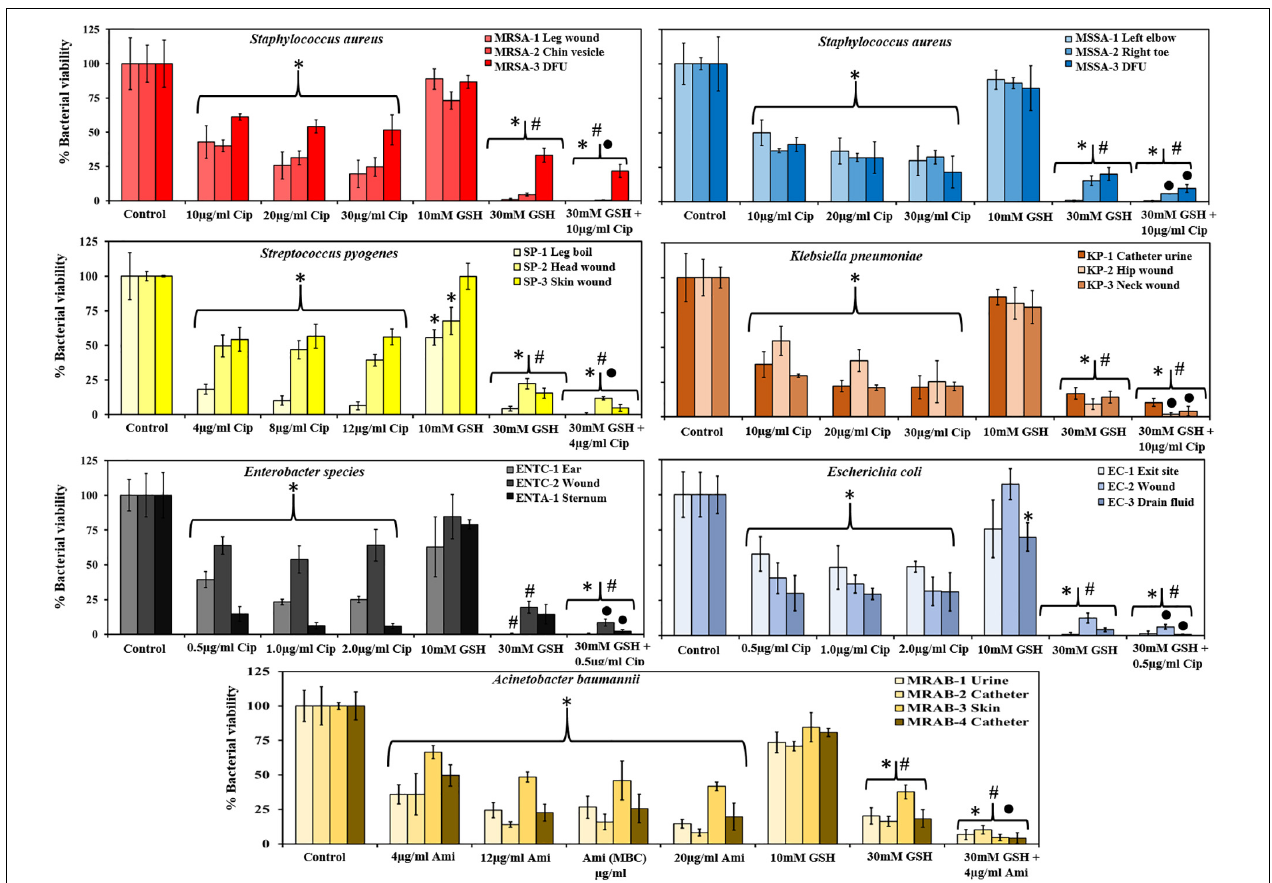
FIGURE 2 | GSH reduces biofilm viability and enhances antibiotic efficiency. GSH showed a concentration-dependent effect in reducing biofilm viability. Ciprofloxacin (1–3 × MIC) significantly reduced biofilm viability of MRSA, MSSA, S. pyogenes , Enterobacter sp., E. coli and K. pneumoniae. For A. baumannii amikacin (1–5 × MIC) significantly reduced biofilm viability when compared to control. 10 mM GSH did not have any effect on biofilm viability, but 30 mM GSH significantly reduced biofilm viability of all bacterial species. A combination of 30 mM GSH and antibiotic of choice further reduced biofilm viability. ∗ P < 0.05 when compared to control, # P < 0.05 when compared to antibiotic at 1 × MIC and • P < 0.05 when compared to 30 mM GSH. Data represent the mean ± SD of n = 4 experiments performed in biological